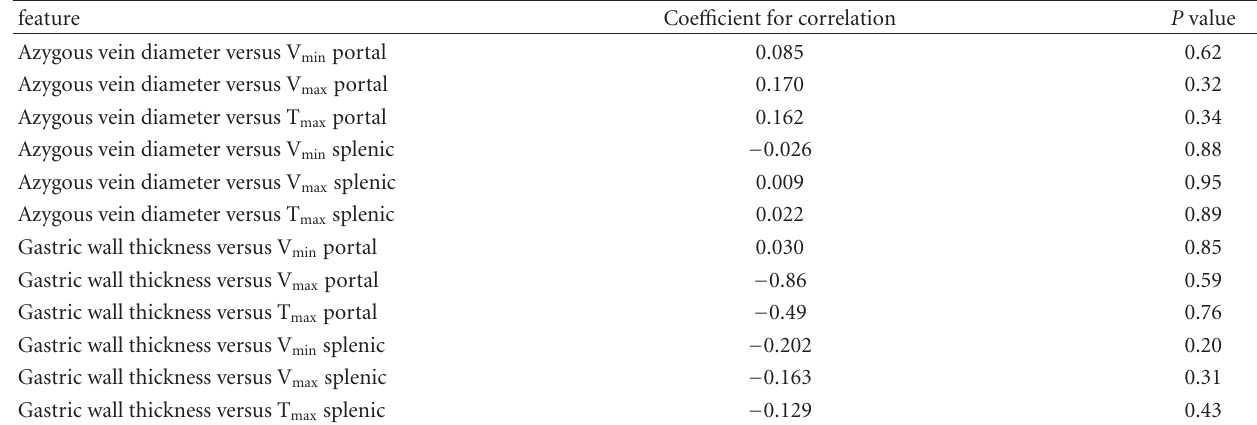
Table 3: Correlation coe ffi cient between the diameter of azygous vein/thickness of gastric wall and flow parameters examined in the patients with liver cirrhosis ( n =